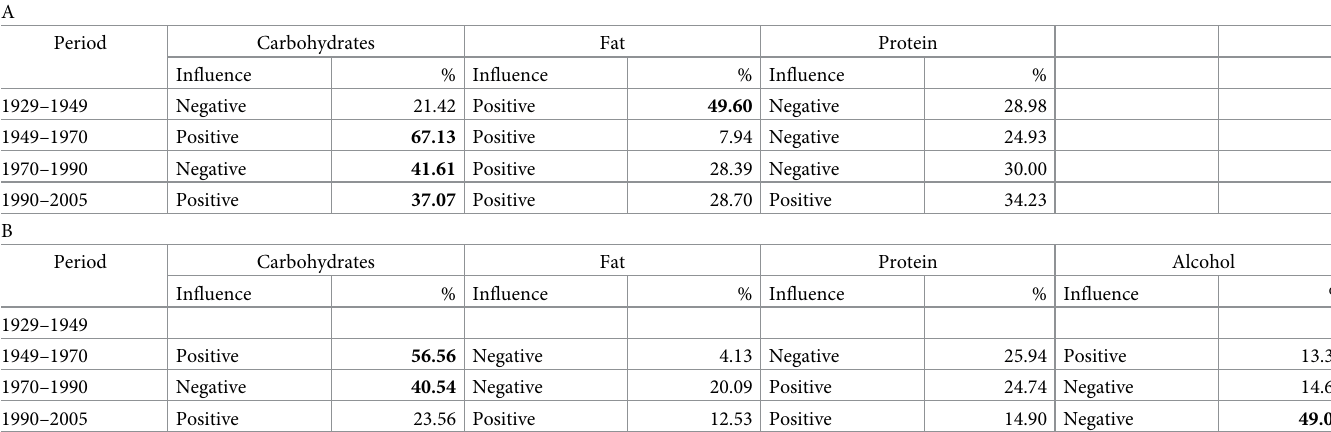
Table 2. The values (positive or negative) of macronutrient coefficients and the strength of the influence (in %) of each macronutrient in each model on R predicted . The strength of influence was calculated using so called “standardized correlation coefficients”. Bold font indicates the nutrient with the highest influence on R predicted . (A) models without alcohol. (B) Models with